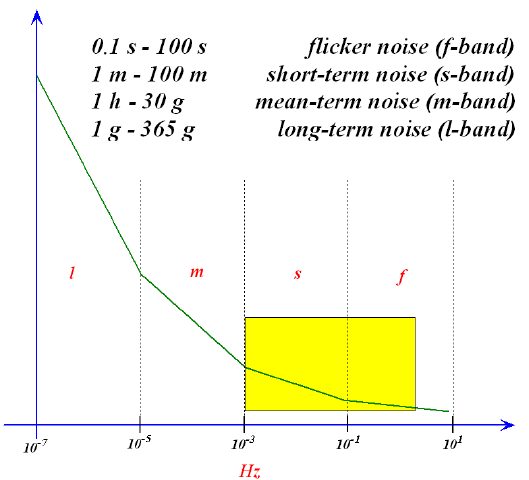
Figure 2. The power spectrum, in arbitrary units, of different geo- magnetic noise bands [Jacobs